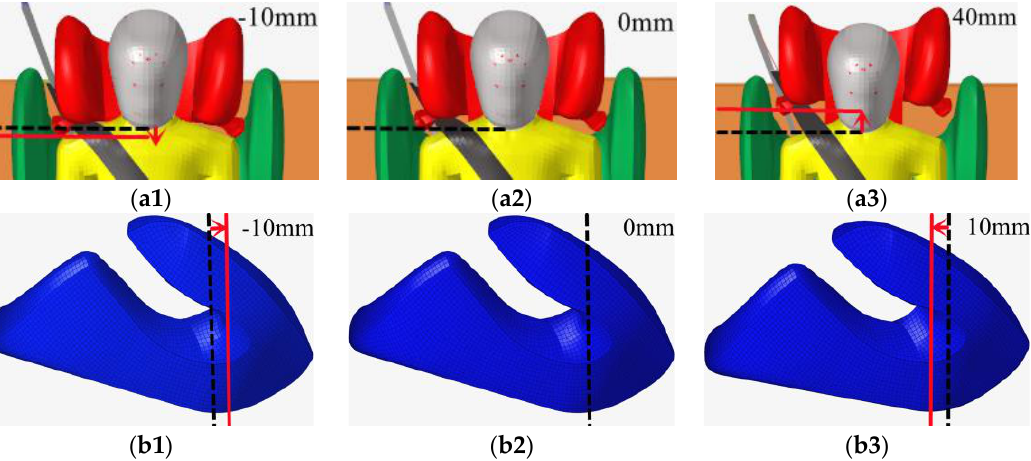
Figure 8. Headrest positions and lap belt guide positions: − 10 mm adjustment ( a1 ), reference position ( a2 ) and 40 mm adjustment ( a3 ) of the headrest; − 10 mm adjustment ( b1 ), reference position ( b2 ) and 10 mm adjustment ( b3 ) of the lap belt guide.